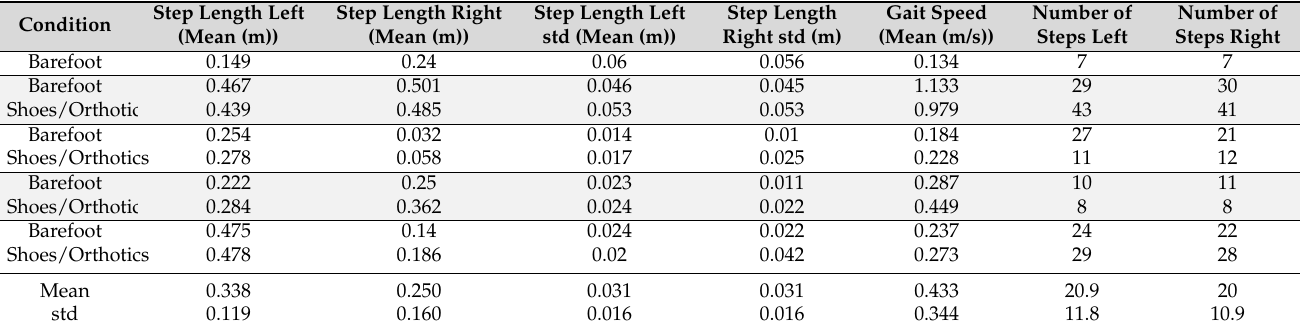
Table 3. Mean and standard deviation (std) of gait parameters in the clinical validation